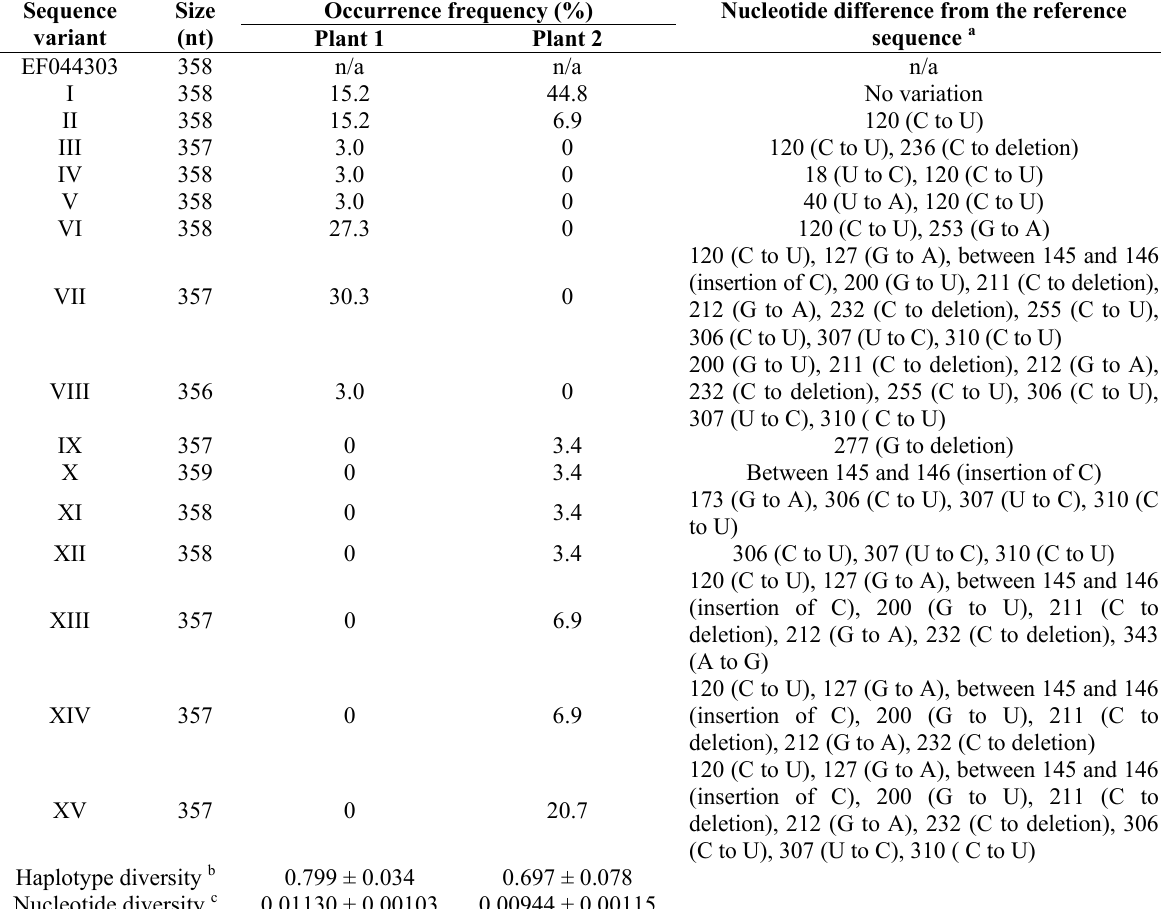
Table 2. Potato spindle tuber viroid (PSTVd) sequence variant population structure, occurrence frequency and nucleotide variation in PSTVd isolate FN-infected tomato